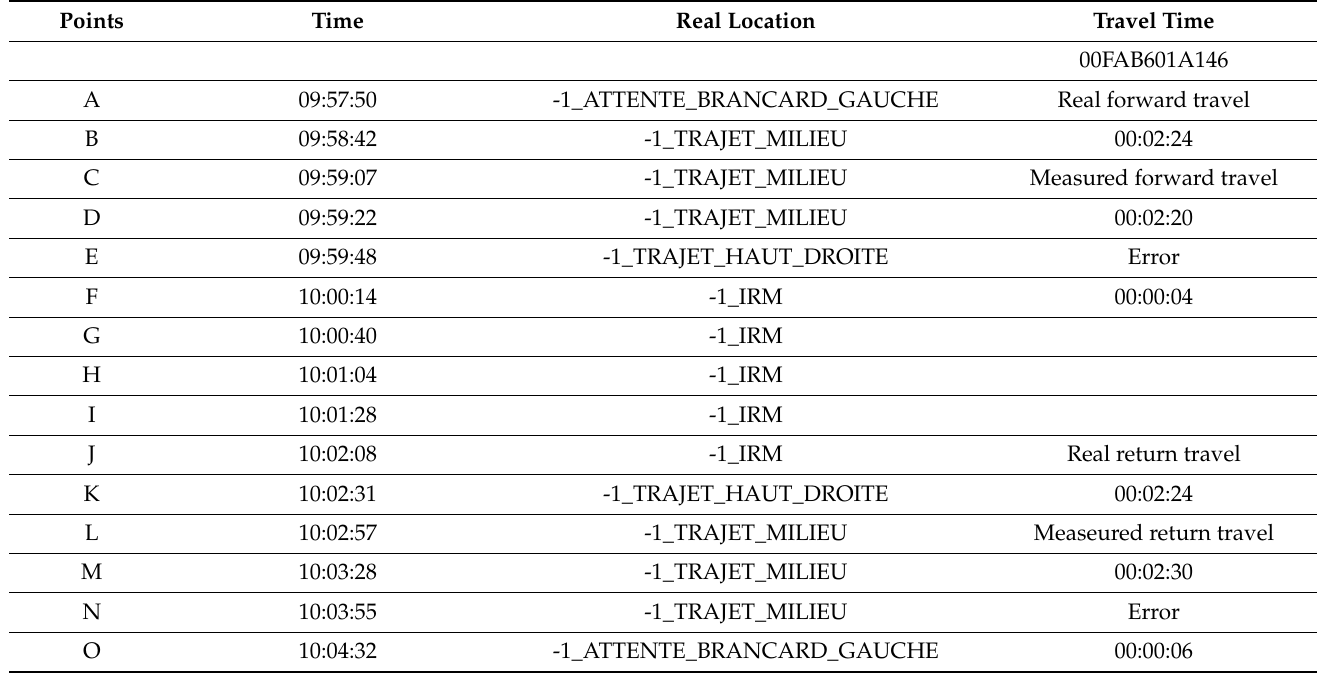
Table 4. Travel time comparison for a given imaging service.